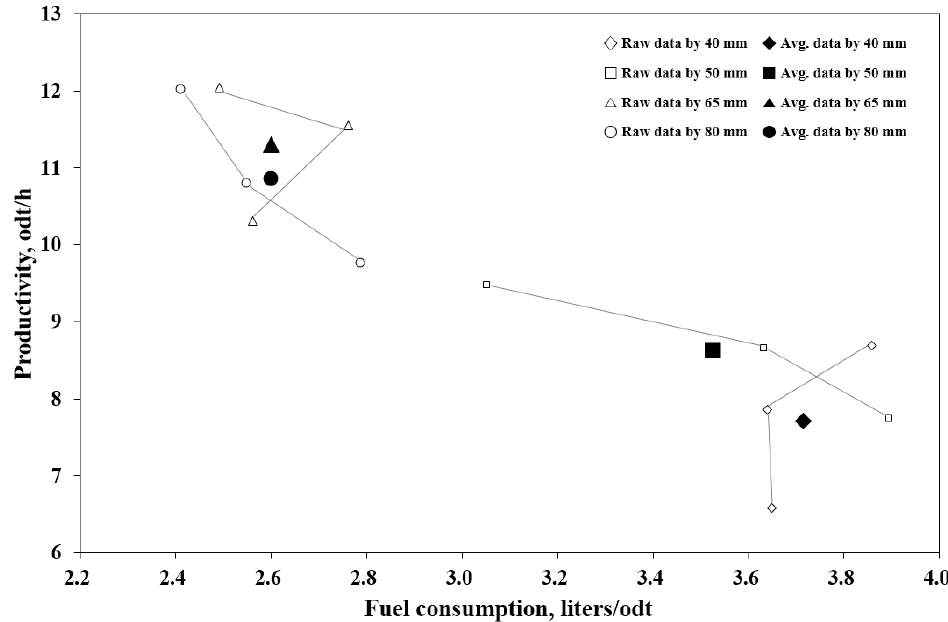
Figure 5. Analysis of the productivity and fuel consumption of the chipping operation by screen size.